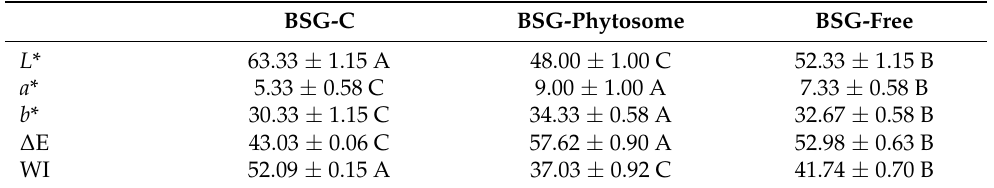
Table 4. Color properties of control modified BSG edible film and those incorporated with tannic acid and vitamin D 3 in the encapsulated form in nanophytosome and free form.